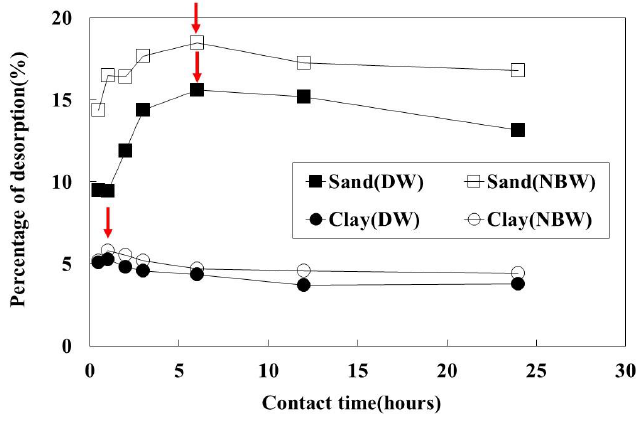
Figure 6. Contact time test (S:L =